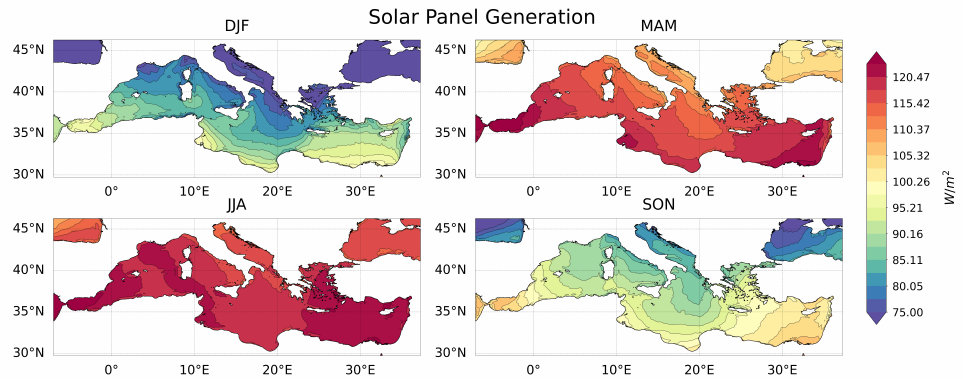
Figure 11. Same as Figure 10 but for the calculated solar panel power